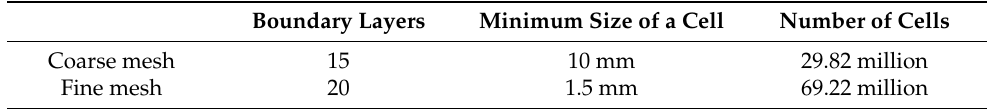
Figure 4. Wind tunnel models: ( a ) the computational train model; ( b ) the train model in the wind tunnel. Meanwhile, in order to determine a proper mesh configuration for the current analysis, two mesh configurations are proposed on the wind tunnel model, just as Table 1 shows. Table 1. Mesh